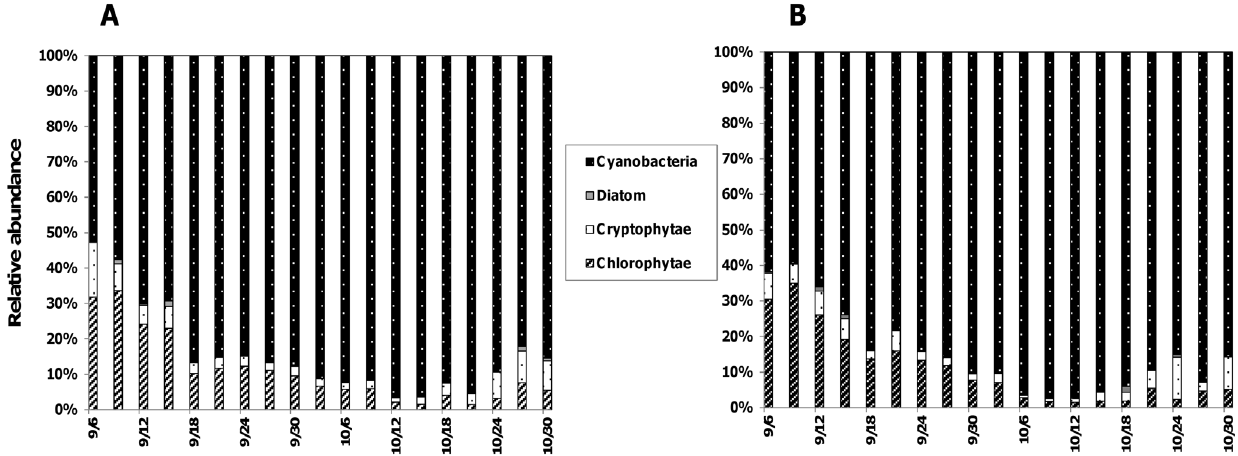
Figure 1. Composition of phytoplanktonic community. Relative contributions of the different taxonomic groups within the phytoplanktonic community at 0.5 m (A) and in the depth of maximum chlorophyll, MF (B) in Lake Aydat, September 6 th to October 30 th 2010.